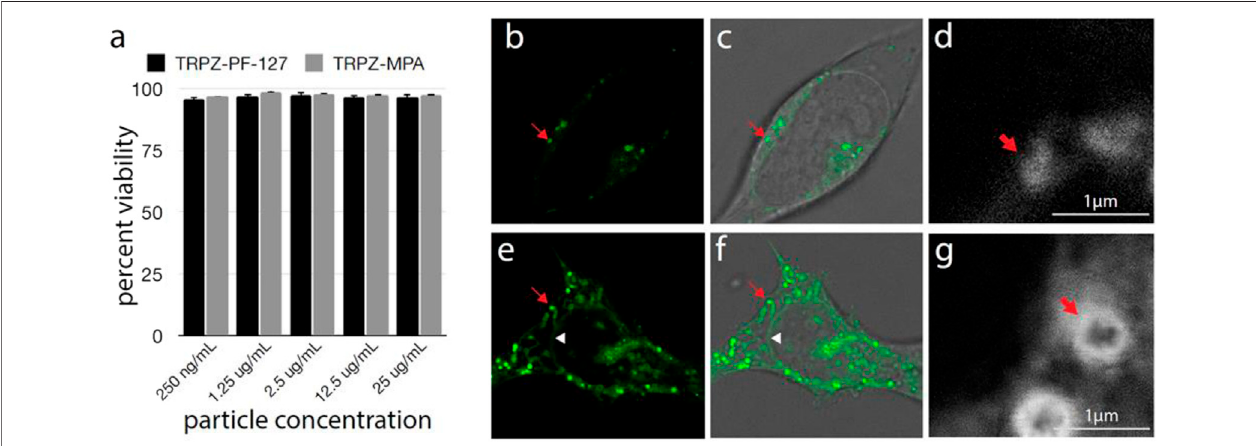
FIGURE 4 | Cell viability and uptake of TRPZ nanoparticles (A) Percent cell viability after treatment with TRPZ-bisMPA NPs and TRPZ-127 NPs. Concentrations tested listed below. No signi fi cant difference was seen between any condition as determined by Tukey ANOVA (B – G) . Fluorescence microscopy of TRPZ-bisMPA NPs (B – D) andTRPZ-127NPs (E – G) localizationaftercellloading.Imageswereacquiredbyconventionalconfocalmicroscopy (B,E) orSTED (D,G) .Bright fi eldimageswere overlaidwith fl uorescenceimaging (C,F) .Redarrowindicatesalabeledlysosome.WhitetriangleinTRPZ-127NPsimagesshowsnuclearmembrane.Enlargement located in the